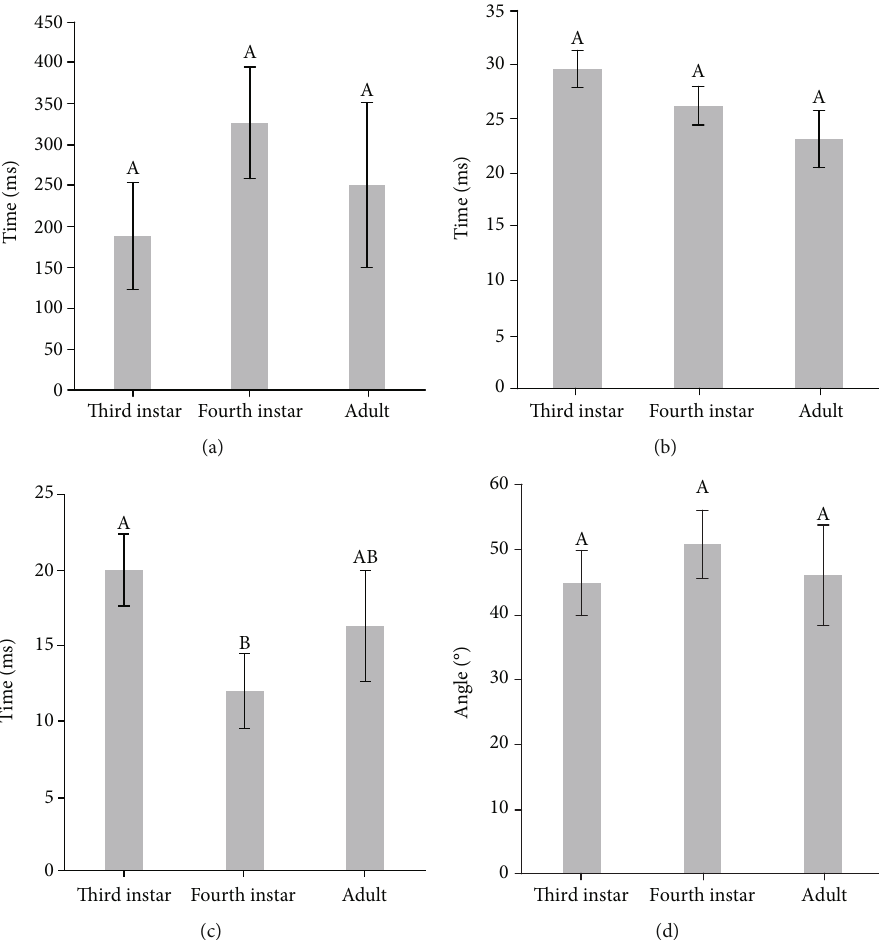
Figure 2: Mean cocking time (a), takeo ff time (b), release time (c), and takeo ff angles (d) of third instar, fourth instar, and adult L. migratoria . Di ff erent letters above each column indicate signi fi cant di ff erences ( P < 0 : 05 ). Whiskers represent standard